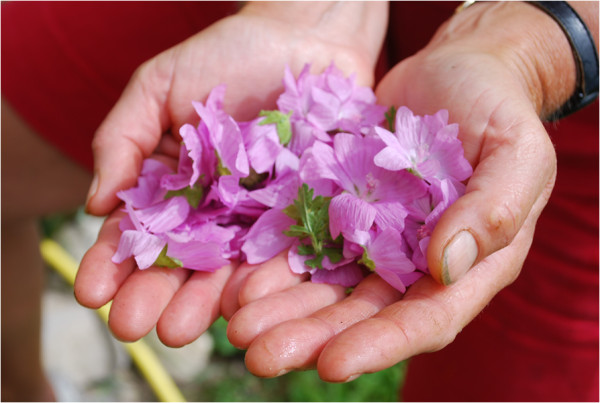
 Malva sylvestrisfor herbal tea (Photo: Susanne Grasser).